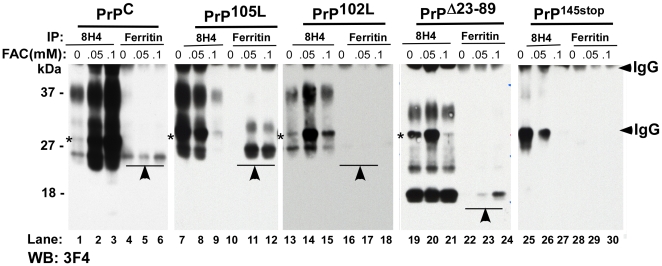
PrP and ferritin co-immunoprecipitate in FAC treated cells.Cell lysates prepared from PrPC, PrP105L, PrP102L, PrPΔ23–89, and PrP145stop-cells exposed to the indicated concentrations of FAC were immunoprecipitated with either anti-PrP antibody 8H4 or anti-ferritin antibody, and eluted proteins were immunoblotted with anti-PrP antibody 3F4. Immunoblotting of 8H4 immunoprecipitates reveals the expected glycoforms of PrP for all cell lines as expected (lanes 1–3, 7–9, 13–15, 19–21, and 25–27). Antibody to ferritin co-immunoprecipitates unglycosylated form of PrPC (lanes 4–6), unglycosylated and diglycosylated forms of PrP105L (lanes 10–12), minimal amounts of unglycosylated PrP102L (lanes 16–18), unglycosylated PrPΔ23–89 (lanes 22–24), and no PrP forms from PrP145stop-cells (lanes 28–30). Co-immunoprecipitated PrP forms increase with increasing concentration of FAC (lanes 4 vs. 6, 10 vs. 12, and 22 vs. 24). A small amount of PrPC co-immunoprecipitates with ferritin even in the absence of FAC (lane 4).